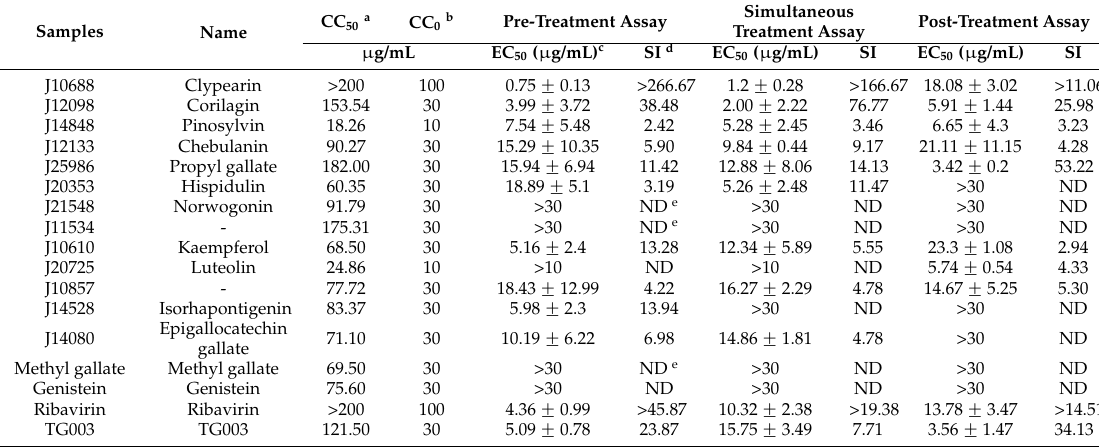
Table 1. In vitro time-of-addition studies on anti-influenza virus activity of CLK1 inhibitors in MDCK cells by CPE reduction assay against